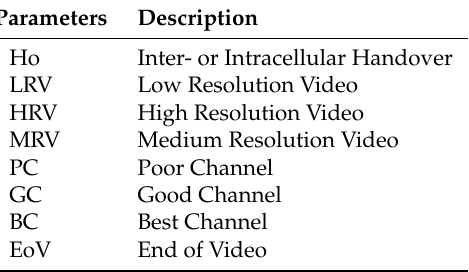
Figure 2. State transition diagram of SCRAS. Table 3. Legends used in Figure